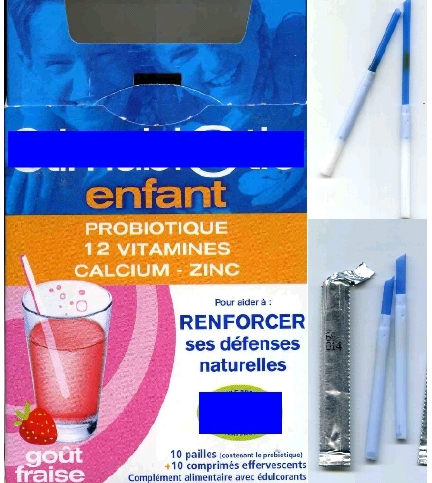
Figure 7. Example of straw used for probiotic suspension.